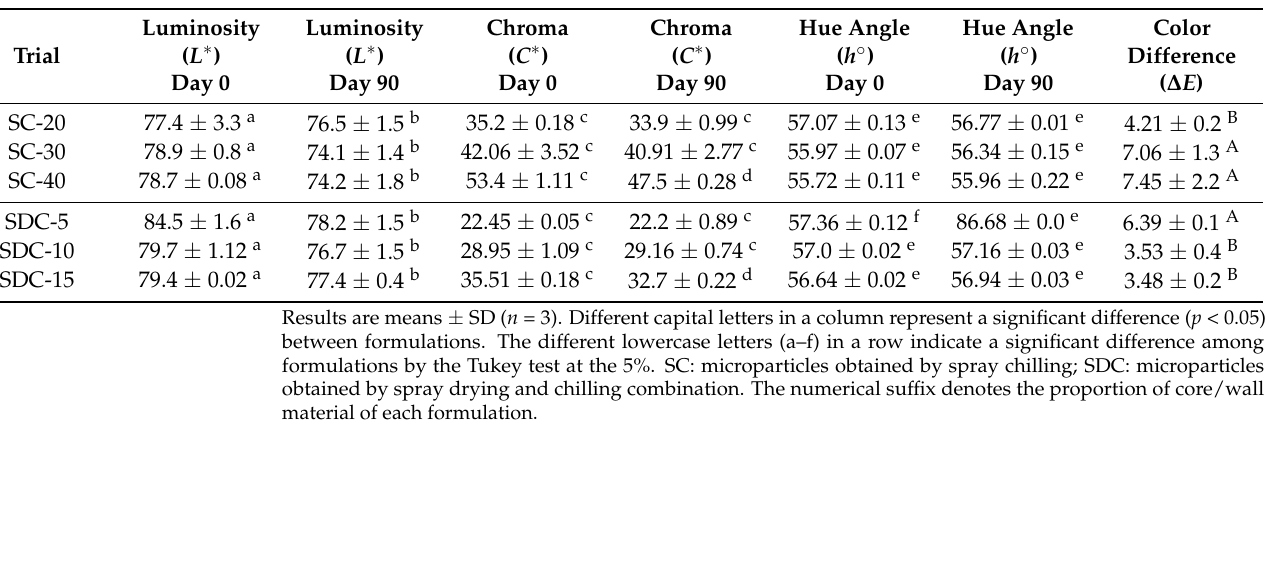
Table 2. Values of instrumental colour parameters during storage of the microparticles measured on days 0 and 90 of storage, at 25 ◦ C and 33% RH